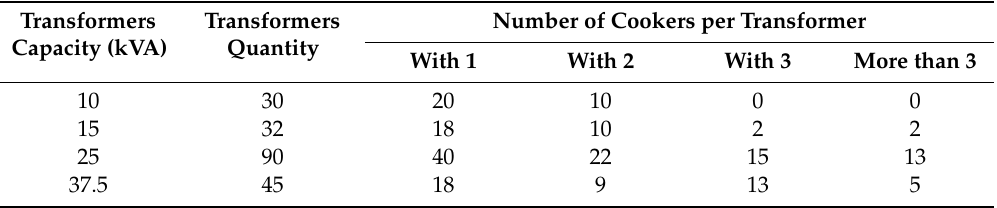
Table 3. Number of cookers per transformer capacity.